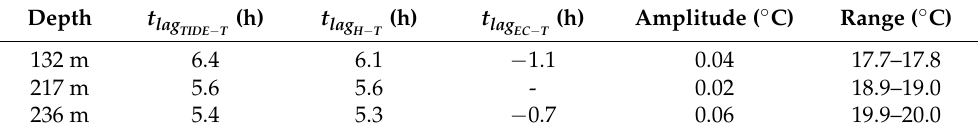
Table 5. Time-lags obtained from the cross-correlation analysis, average amplitudes of the temper- ature oscillations, and temperature ranges of the dataset for February 2018. t lag between tide and temperature, t lag is the delay between hydraulic head and temperature, t lag H − T is the delay between electrical conductivity and temperature.